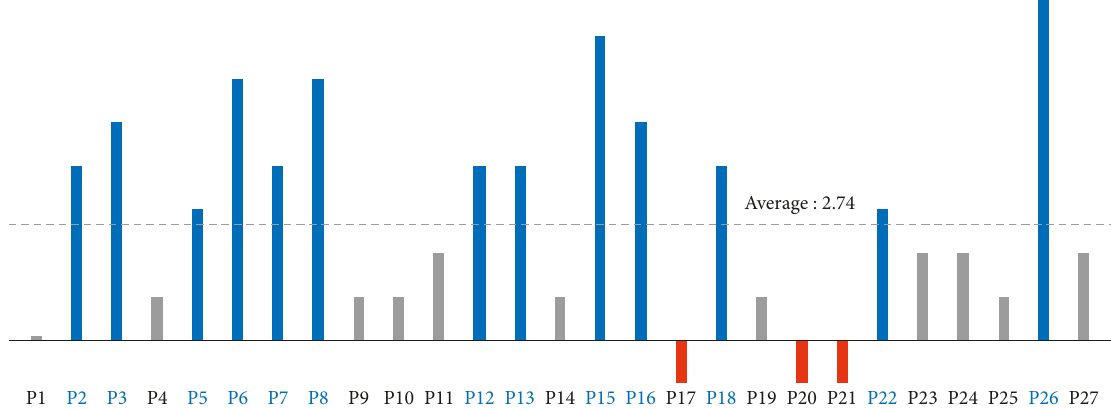
Figure 3: Scores on positive and negative benefits of using digital